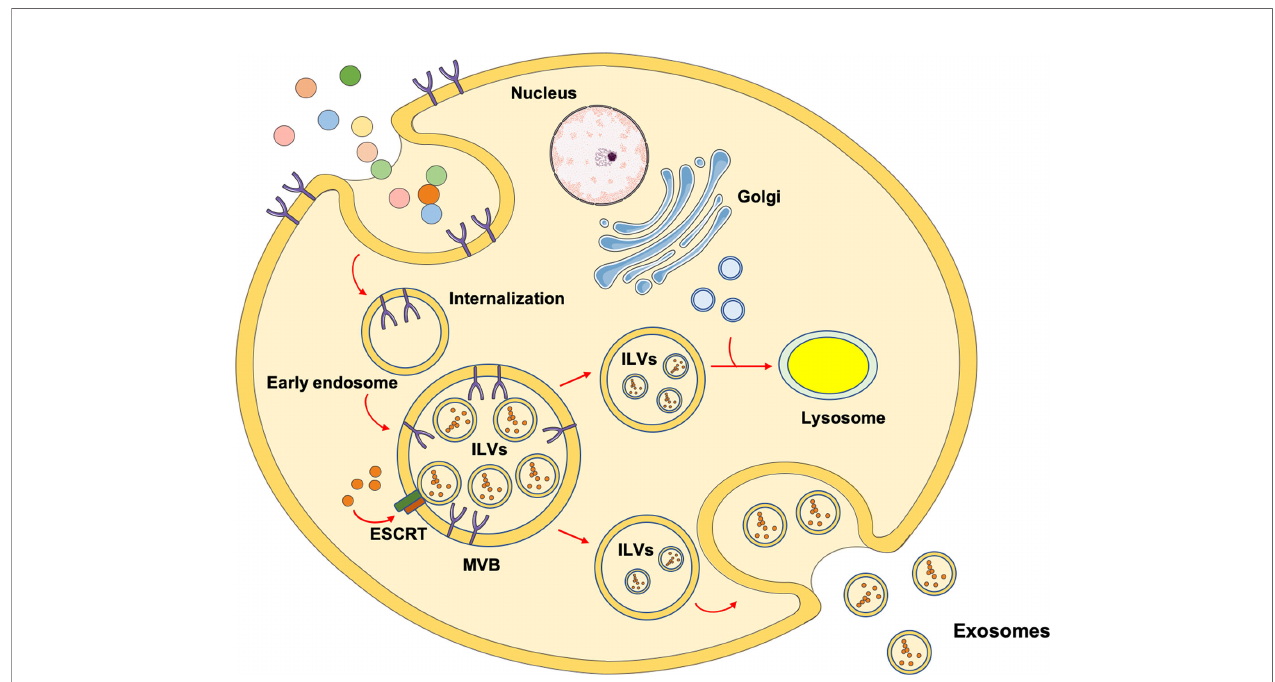
FIGURE 1 | Schematic representation of the mechanisms involved in exosomes biogenesis. The most investigated mechanism through which exosomes are generated involves endocytosis after receptor/ligand binding at the cell ’ s membrane. After the ligand dissociates from its receptor, it is located into an early endosome. The receptor can either be recycled and relocated on the membrane surface or degraded into lysosomes. Through the activity of the endosomal sorting complex request for transport (ESCRT), the early endosome maturates into multivesicular bodies (MVBs) containing intraluminal vesicles (ILVs). Eventually, MVBs migrate toward the plasma membrane and fuse to release ILVs as exosomes. As an alternative route, MVBs can fuse with other MVBs or late endosomes and receive vesicles containing lysosomal enzymes from trans Golgi, evolving into lysosomes for degradative